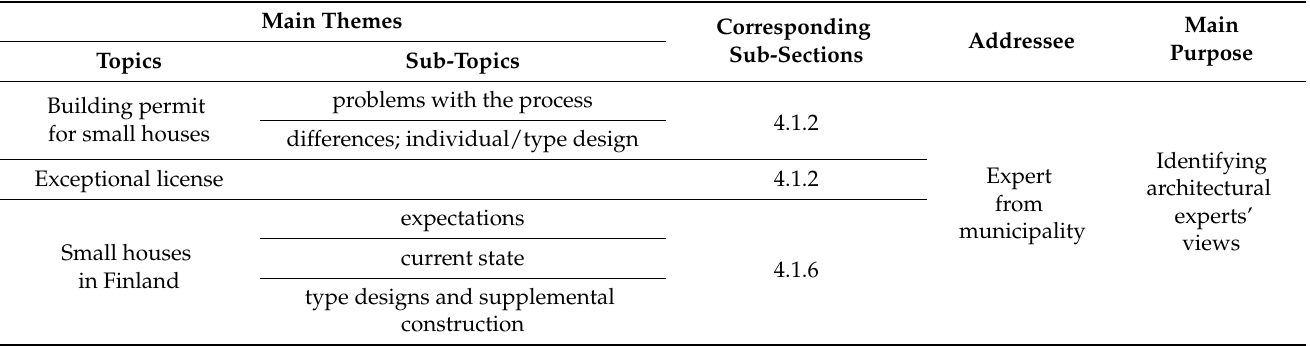
Table 5. The main themes, addressee, and main purpose of the interview questions (Appendix